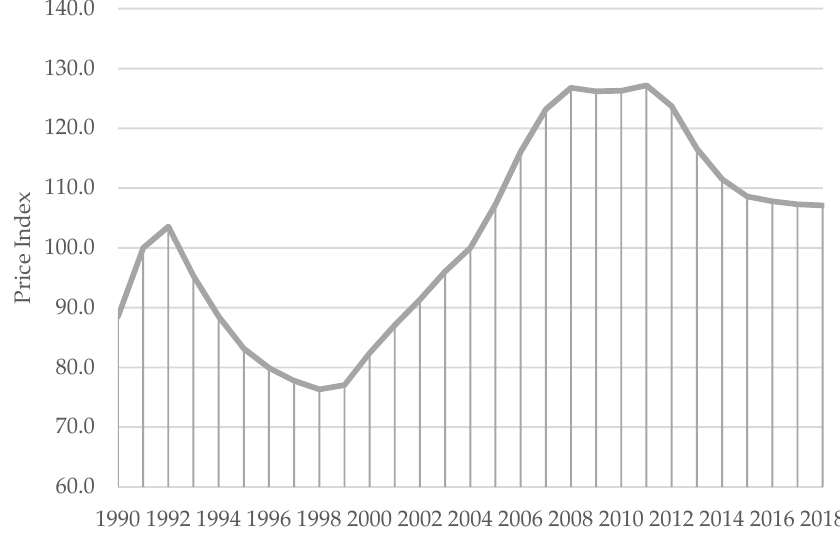
Figure 1. House price index in Italy in the period 1990–2018 (2004 = 100).